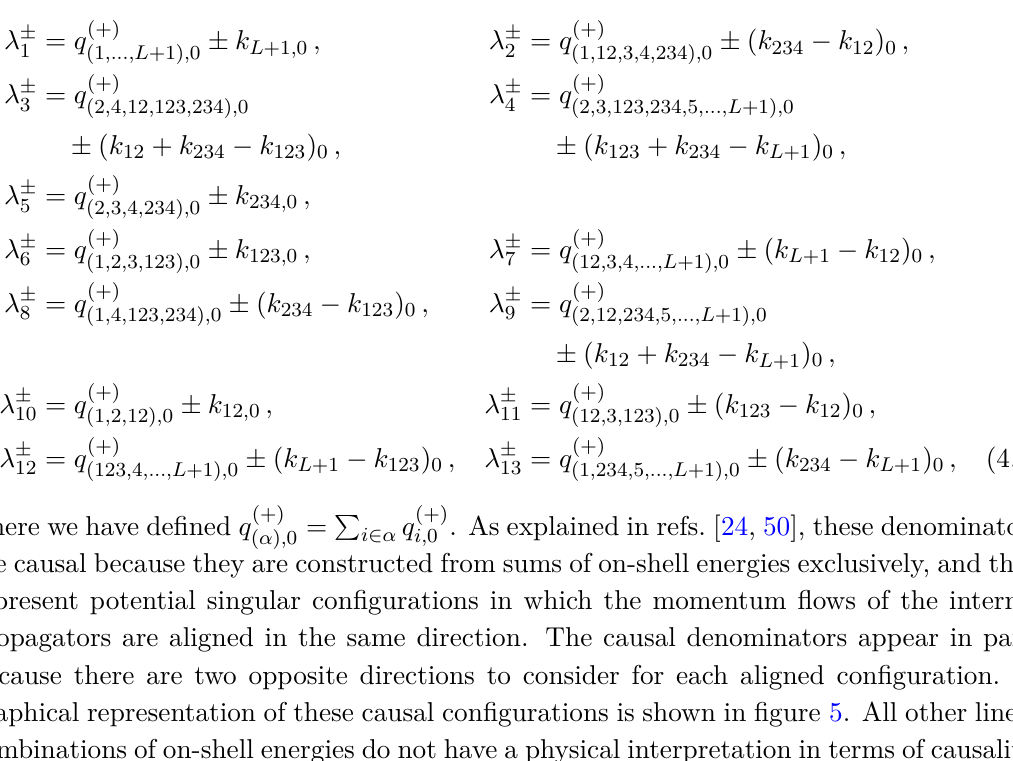
Figure 5 . Causal configurations of the N 3 MLT topology. The λ − reversing the momentum flows of the corresponding λ + 5 accounts for all the propagators in the sets 5 to L + 1